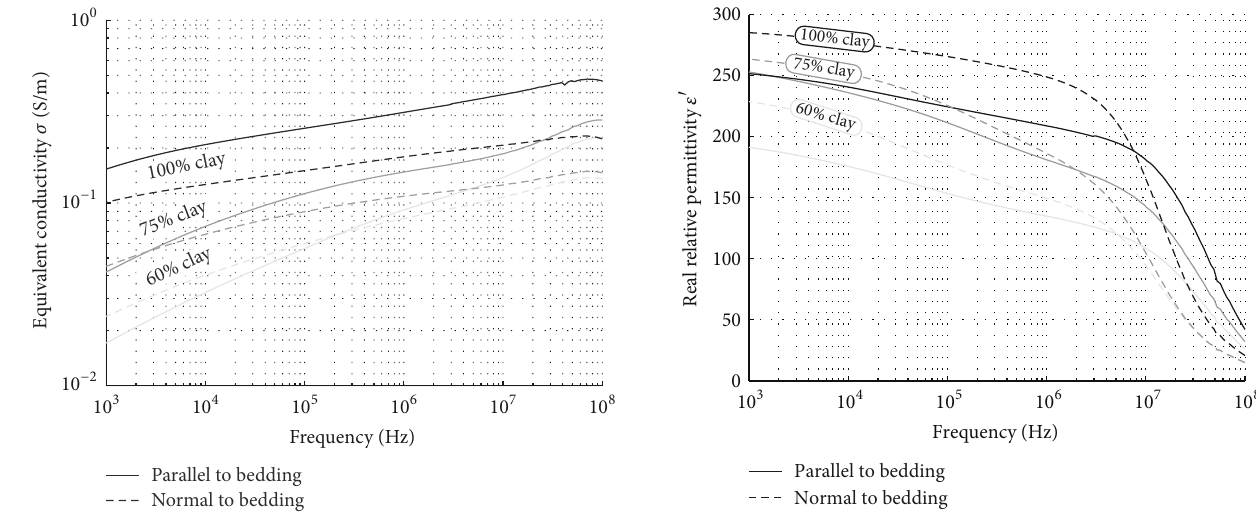
Figure 9: Effect of clay content on frequency dependent conductiv- ity in samples measured parallel and normal to the bedding plane.